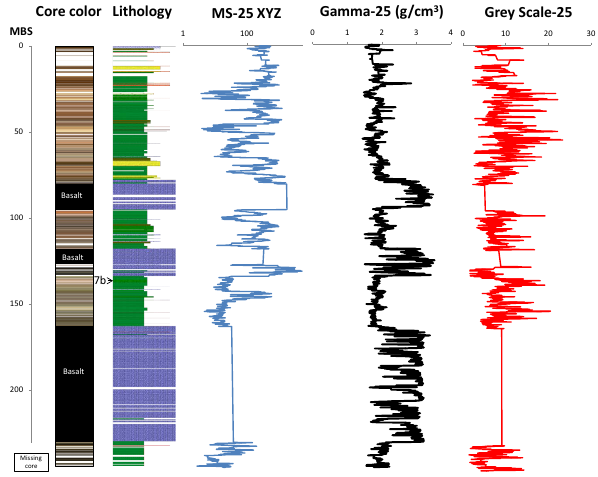
Figure 6. Summary stratigraphy of core HSPDP-NAW14-1A, from the Woranso locality, Northern Awash drilling area, northern Ethiopia, based on initial core description results. Columns from left to right: core color stratigraphy; lithologic log; see Fig. 5 for the key to lithologies used in all cores illustrated; composite of mag- netic susceptibility (MS) log data (25-point running mean smooth) from LacCore Geotek © XYZ point sensor data; composite of in- duced gamma density log data (25-point running mean smooth, spu- rious values <1.4gmcm − 3 removed); composite of spectrophoto- metric grey-scale log data (25-point running mean smooth). All data collection, instrumentation, and parameters as in Fig.